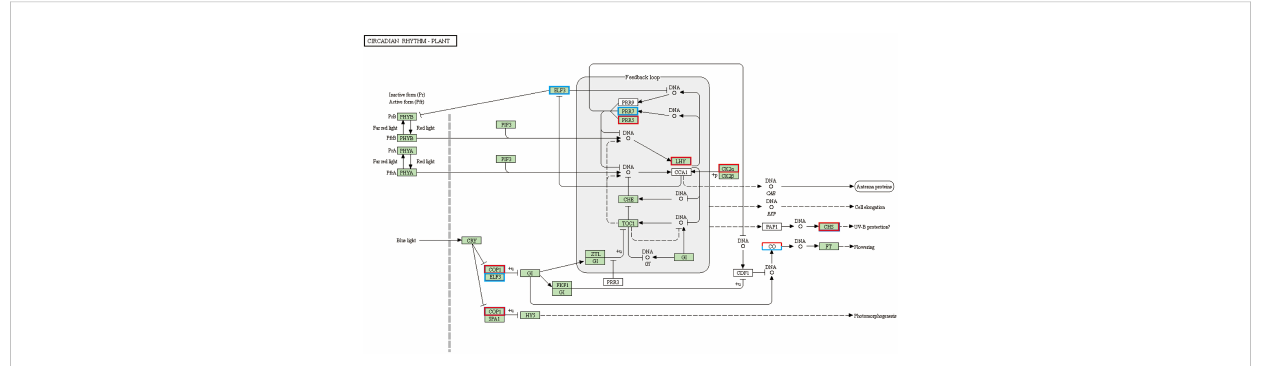
FIGURE 3 Integrated pathway mapping of circadian rhythm related DEGs. DEGs were selected based on the KEGG enrichment (Red indicates up-regulated and blue indicates